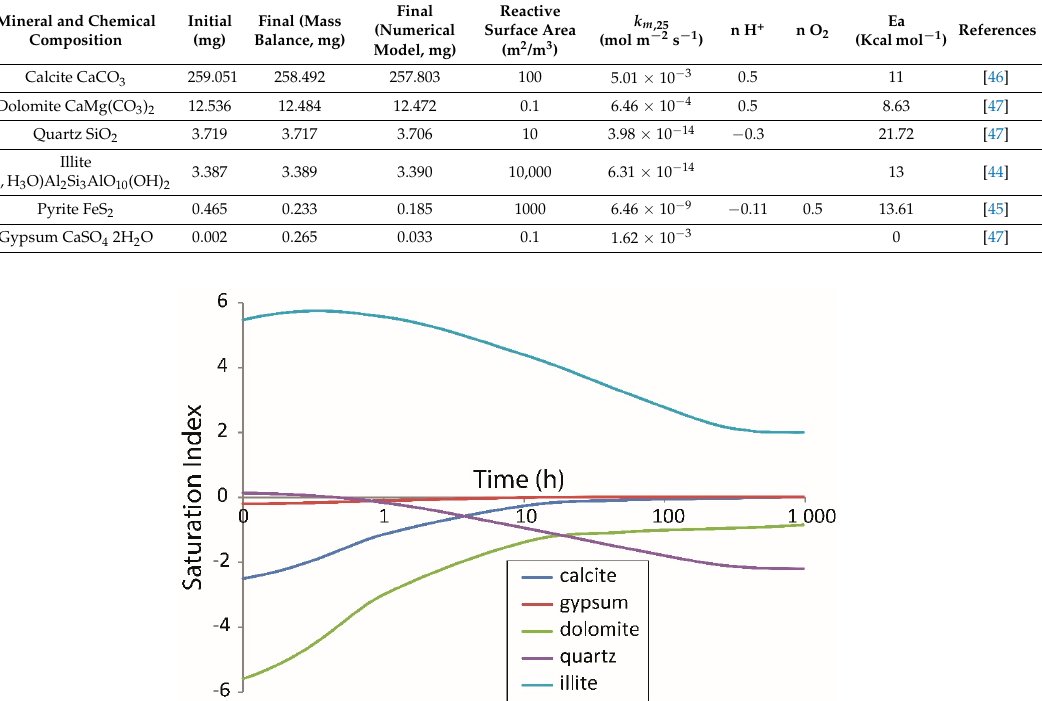
Figure 5. Evolution of the saturation index for the different minerals over the batch experiment time obtained by the numerical simulation performed on CrunchFlow.